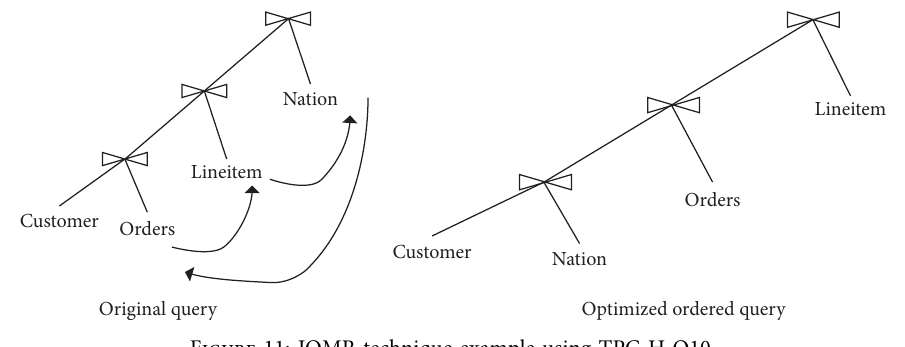
Figure 11: JOMR technique example using TPC-H Q10.